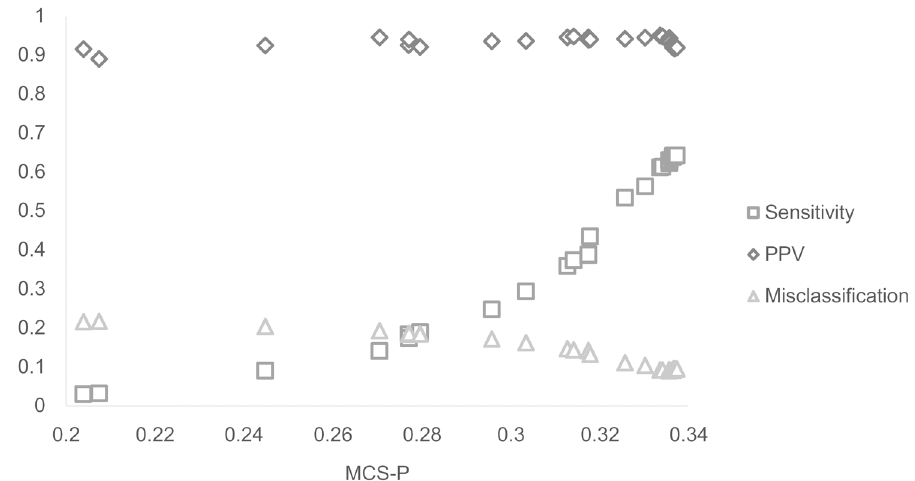
Fig 1. Average MCS-P and other measures in